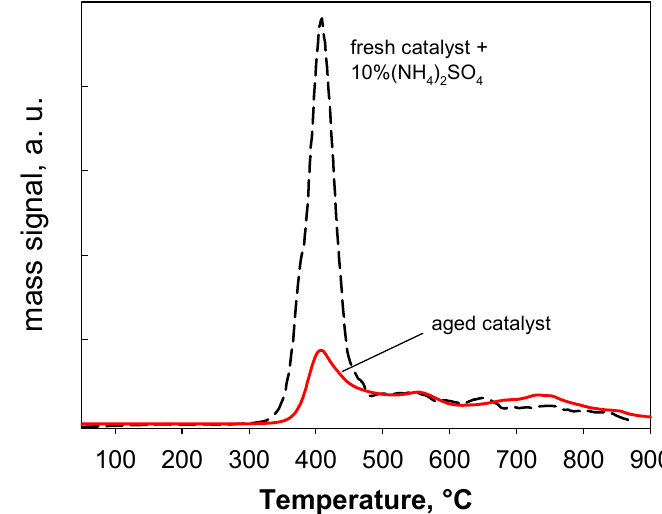
Figure 7. MS profiles of SO 2 ( m / z = 64) recorded during the TG analysis (Figure 6) of the fresh catalyst sample impregnated with 10 wt% (NH 4 ) 2 SO 4 and the 18 kh reaction-aged catalyst.